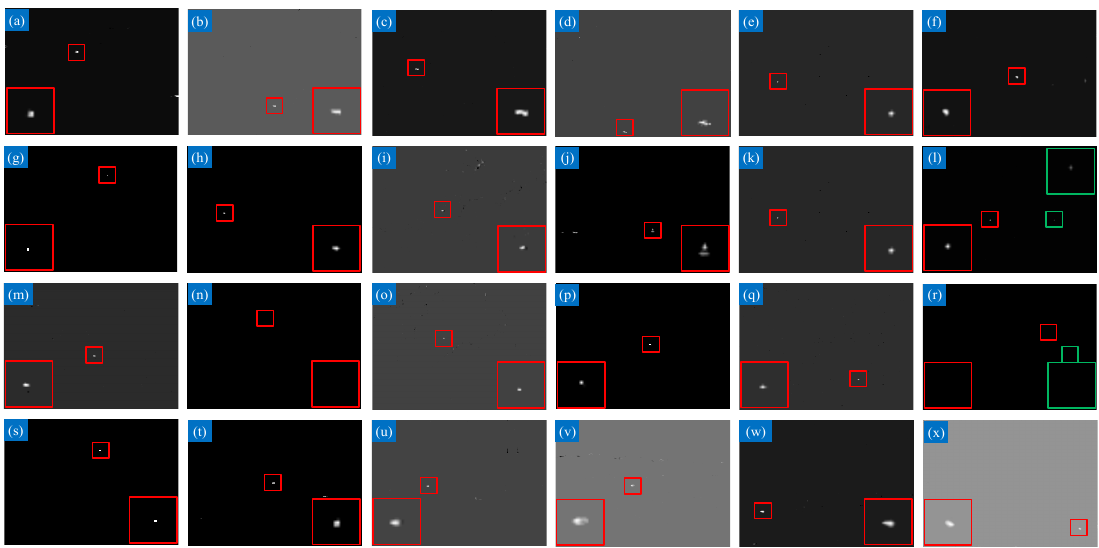
Figure A6. The separated target images of NIPPS under 24 scenes.